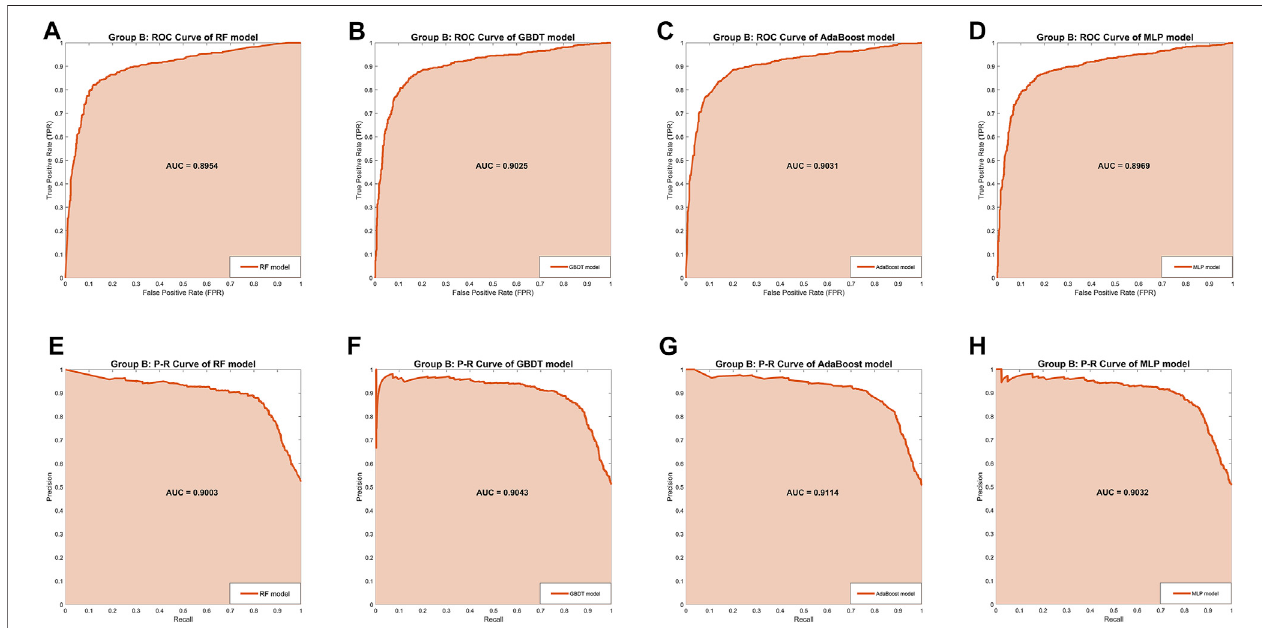
FIGURE 3 | The ROC curves and P-R curves of the four models in Group B. (A – D) The ROC curves and AUC scores of four models in Group B: the dark orange curve refers to the ROC curve, the area under the curve is covered by light orange color and the AUC score is clearly marked. (E – H) The P-R curves and AUC scores of four models in Group A: the dark orange curve refers to the P-R curve, the area under the curve is covered by light orange color and the AUC score is clearly marked.